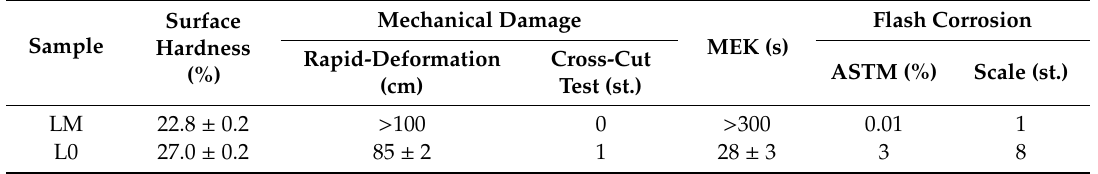
0 Table 8. Antimicrobial efficiency of non-pigment coating films (test on imprints). Sample